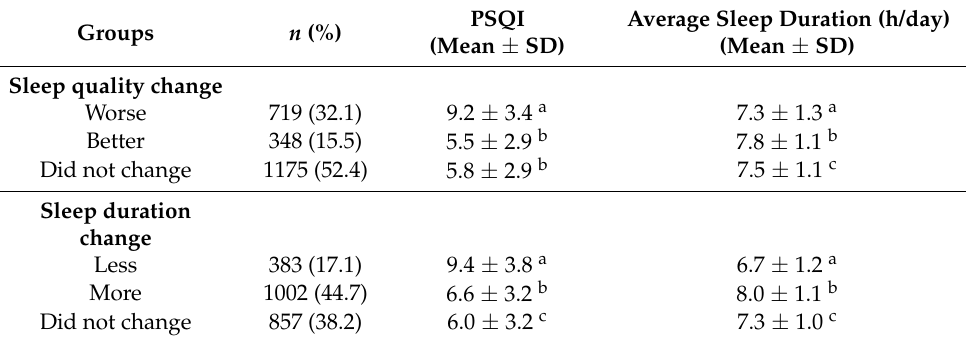
Table 6. PSQI and average sleep duration of sleep quality and duration change